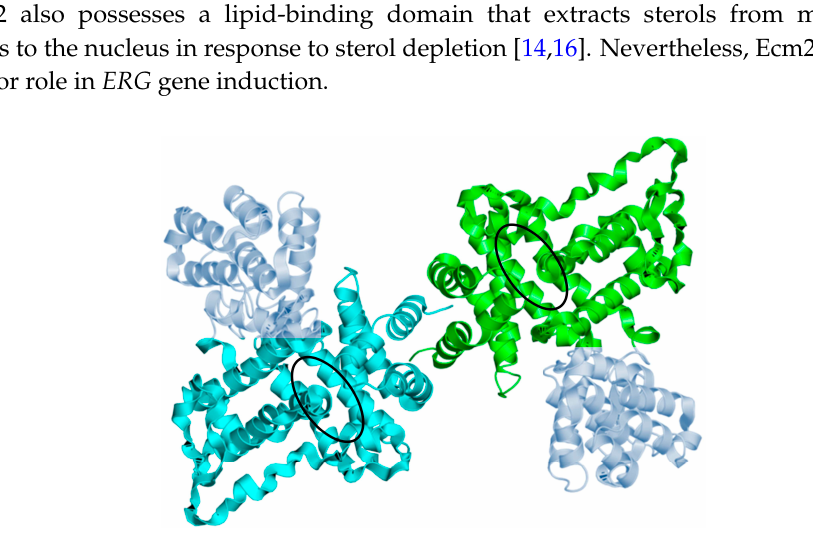
Figure 3. Crystal structure of the Upc2 lipid-binding domain. The lipid-binding domain forms dimers shown in green and turquoise (PDB 4N9N). To improve diffraction quality for crystallographic studies, a T4 lysozyme has been inserted between helix 5 and 6 (shown in light blue) [14]. The hydrophobic pockets are shown by the black ellipses.